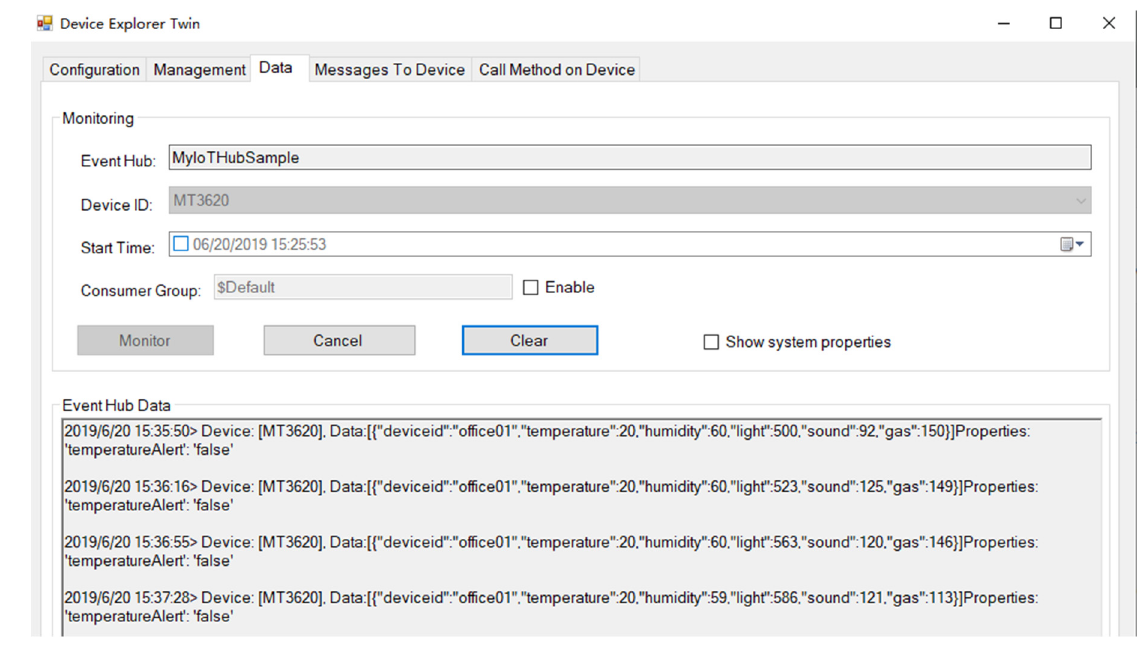
Figure 10. UART Waveforms: ( a ) Transmit; ( b ) Receive.